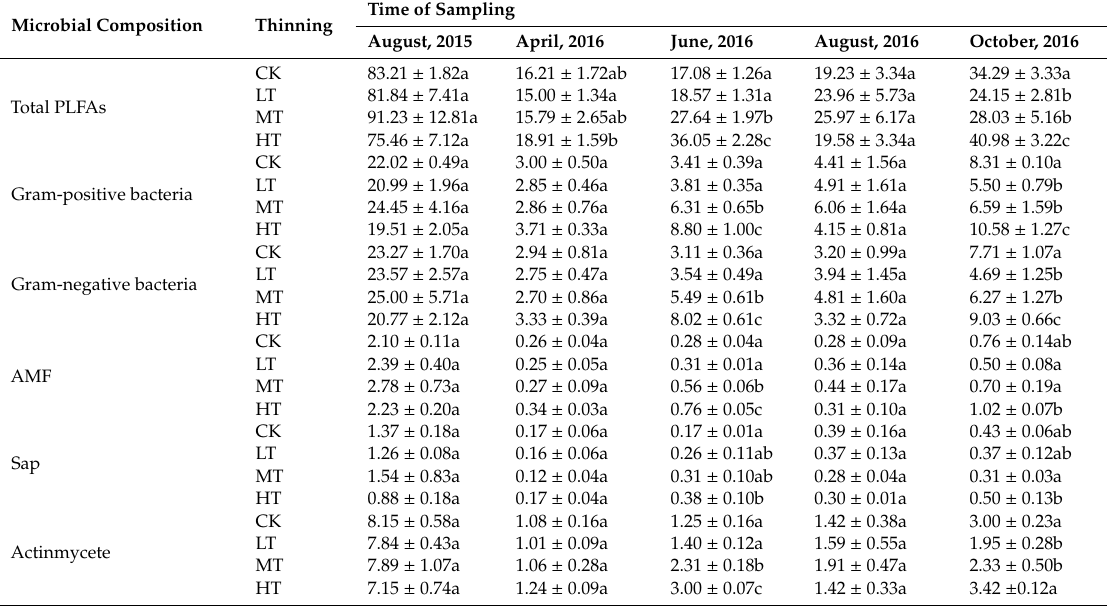
Table 3. Soil microbial PLFAs in di ff erent thinning treatments. Time of Sampling Microbial Composition Thinning